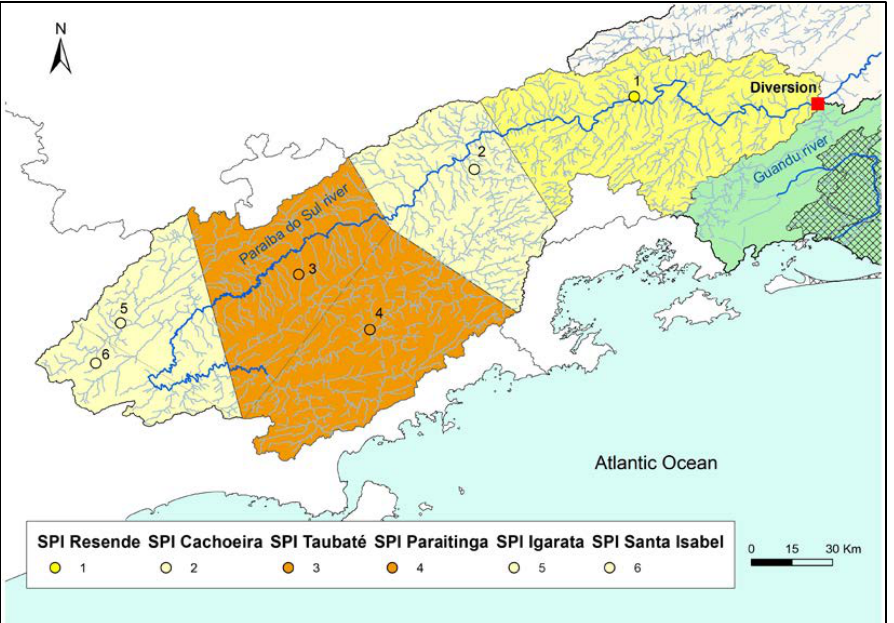
Figure 6. Monthly SPI of rainfall gauges in the region under study.